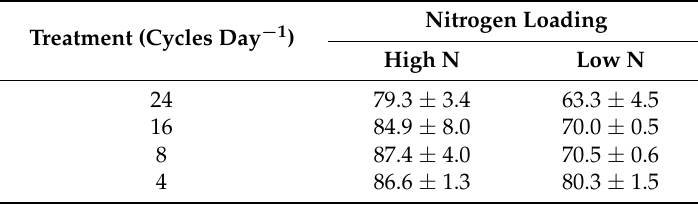
Table 2. Average and standard error for N removal efficiency (%) in the High- and Low-N columns during each cycling